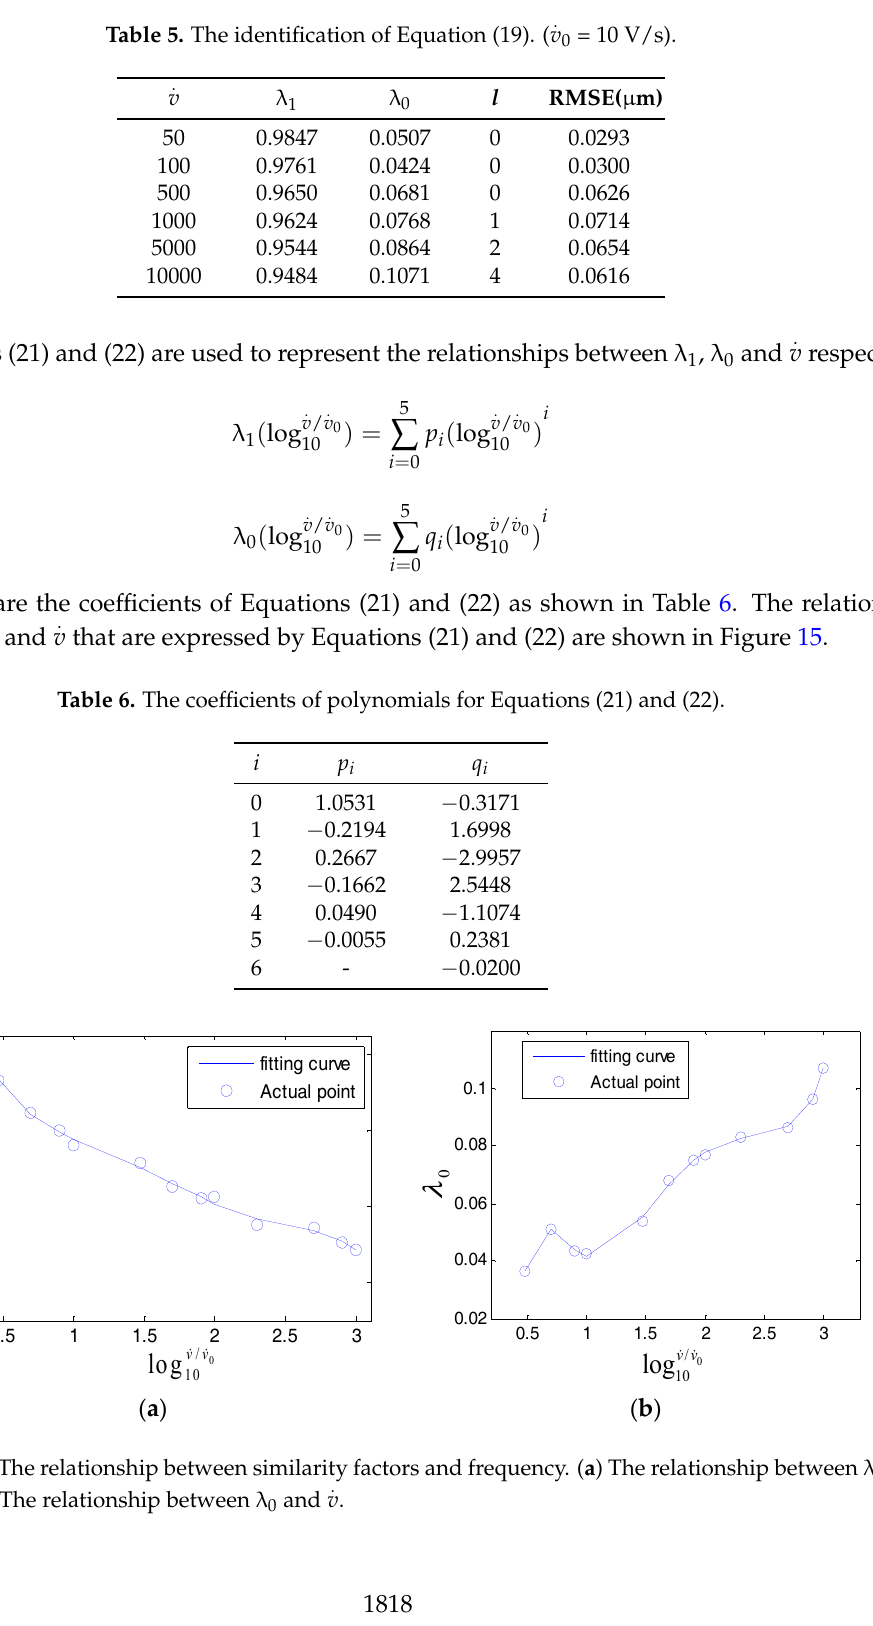
Table 5. The identification of Equation (19). (